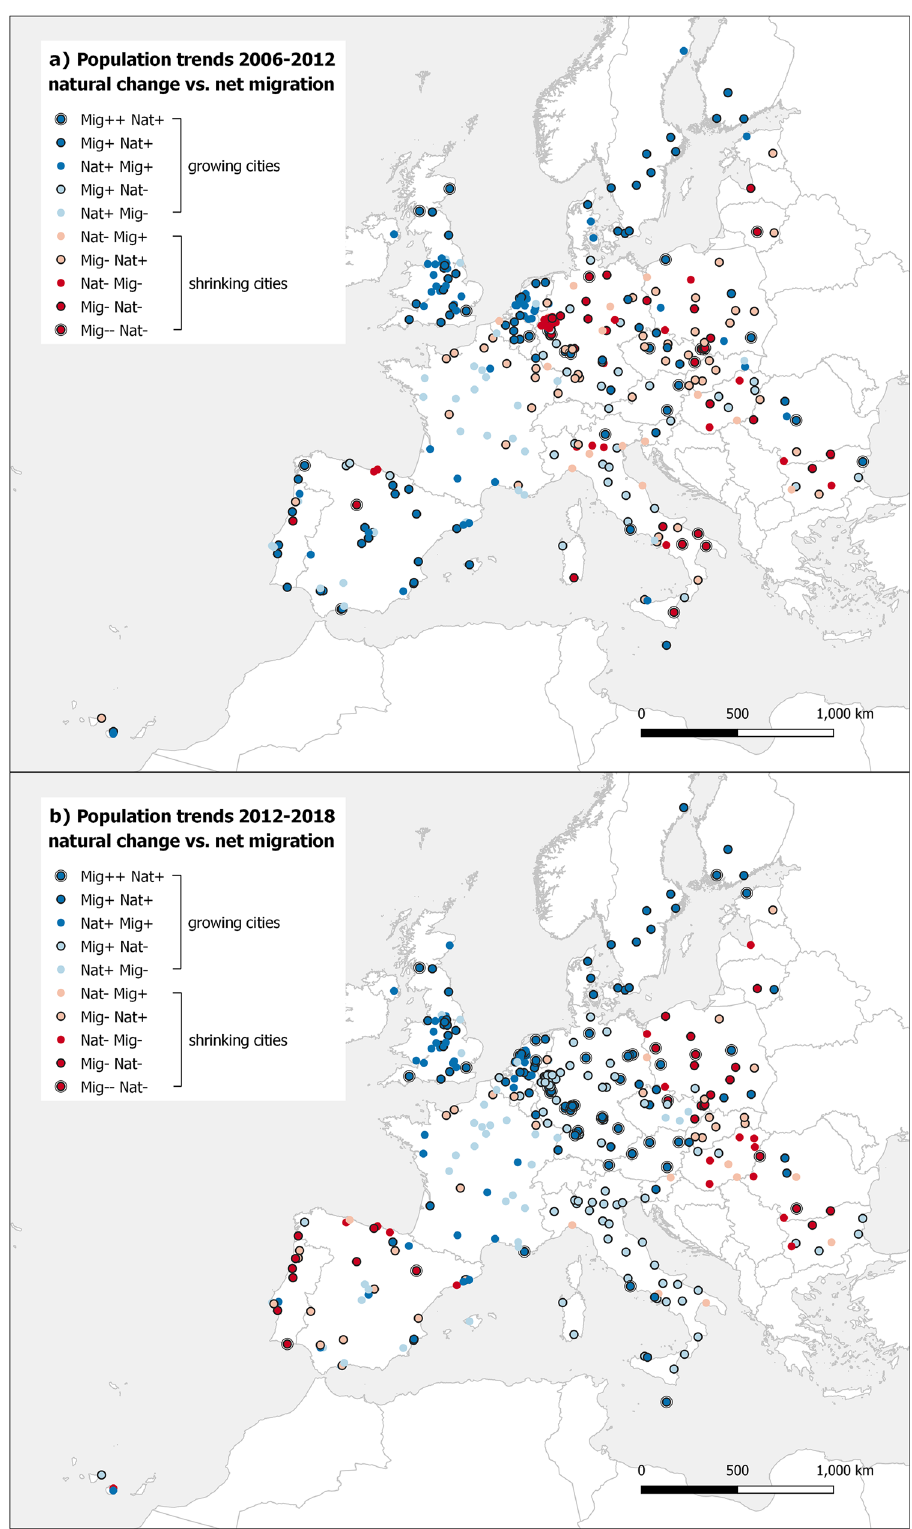
Fig. 5 Population trends in 2006 – 2012 and 2012 – 2018 broken down into natural change and net migration. Nat = natural change, Mig = net migration. Red dots correspond to shrinking cities, blue dots to growing cities (see Fig. 2 panels c and d). The trend cited fi rst in the legend is the prevailing one (circles with a black outline indicate prevailing migration, circles without outline indicate prevailing natural change). The signs + and – in the legend indicate positive and negative change respectively; ++ and – – signal cases in which the contribution of net migration is at least 5 times greater than that of natural change. Light hues are used when the two trends are contrasting (i.e., one positive and the other one negative), dark hues that they are concordant (i.e., both positive or both negative). Panel ( a ) refers to the period 2006 – 2012, panel ( b ) refers to the period 2012 –